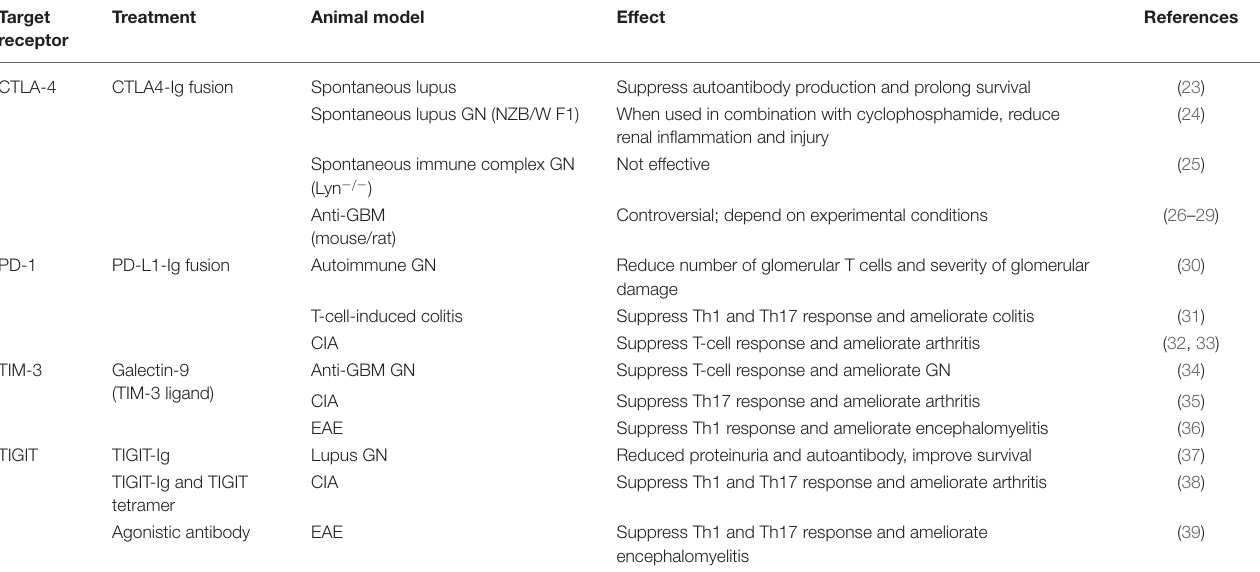
TABLE 1 | Experimental treatment models targeting T-cell co-inhibitory signaling in autoimmune diseases. Target